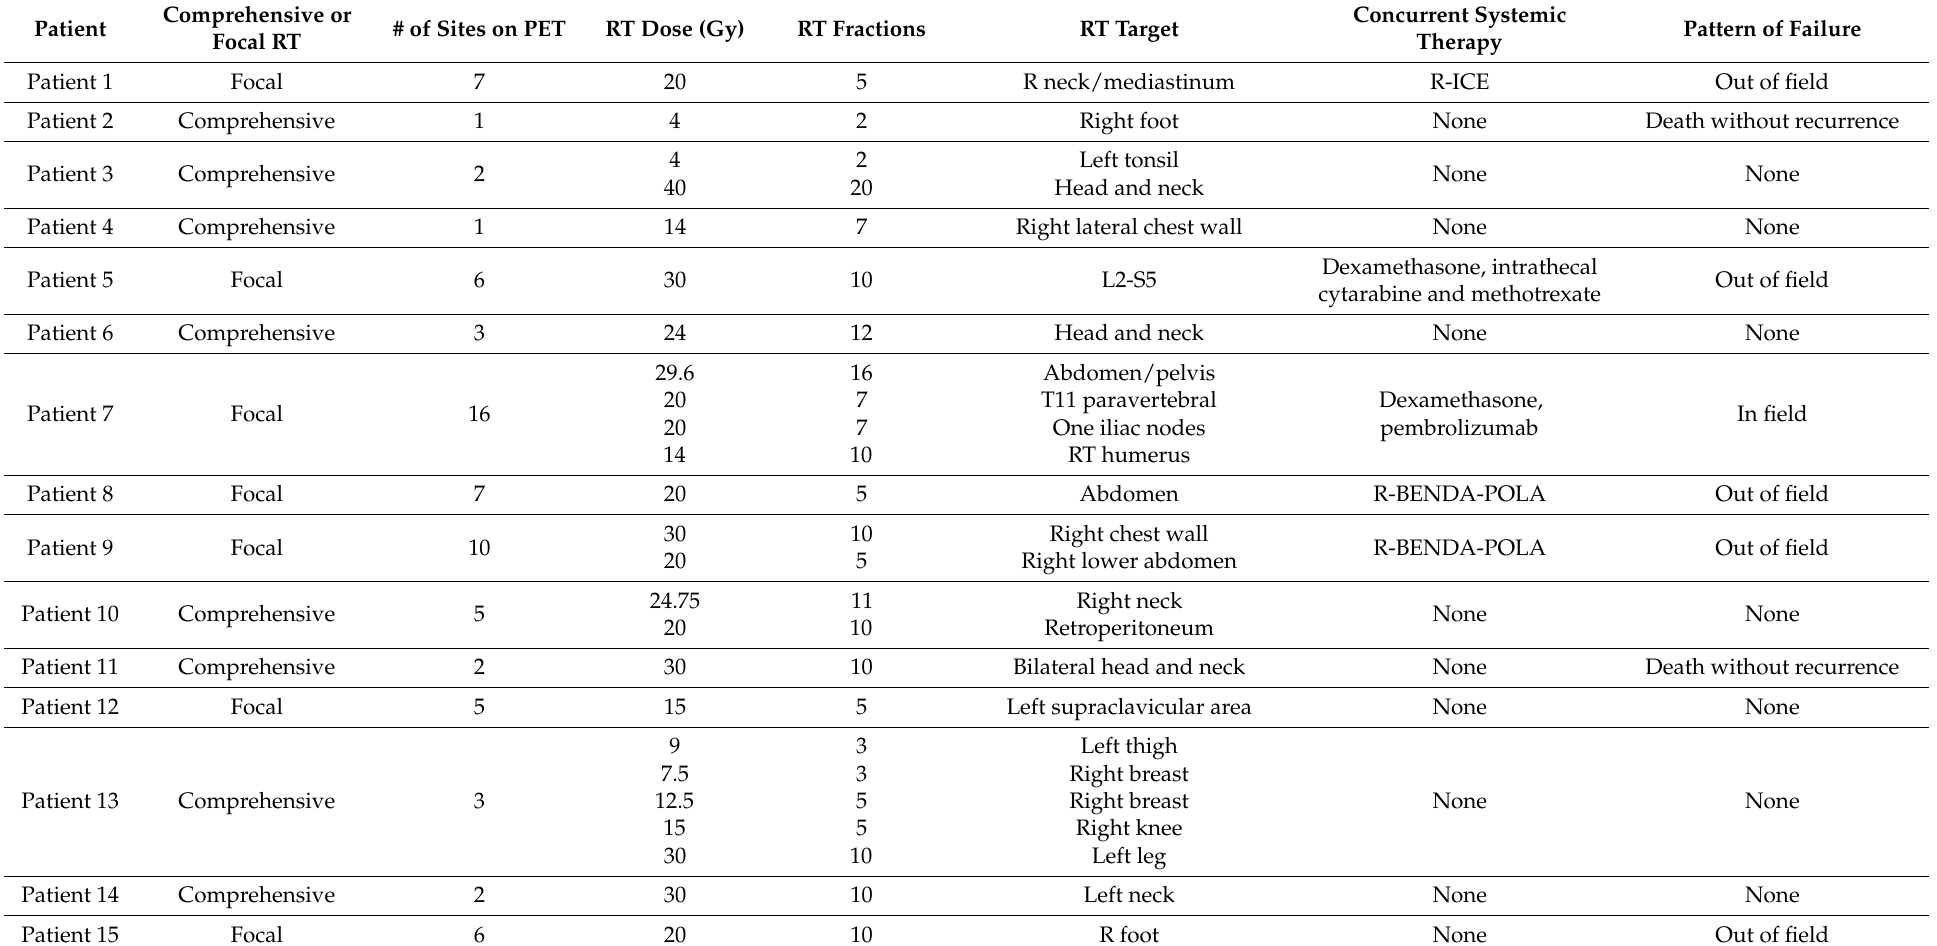
Table 2. Details of patients who received bridging therapy with radiation or combined-modality